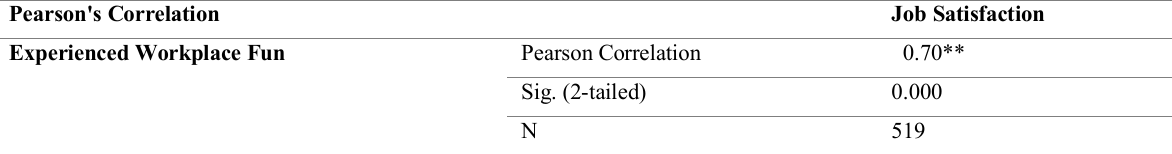
Table 8: Pearson’s Correlation conducted to test relationship between experienced workplace fun and job satisfaction Pearson's Correlation Job Satisfaction Experienced Workplace Fun Pearson Correlation 0.70**